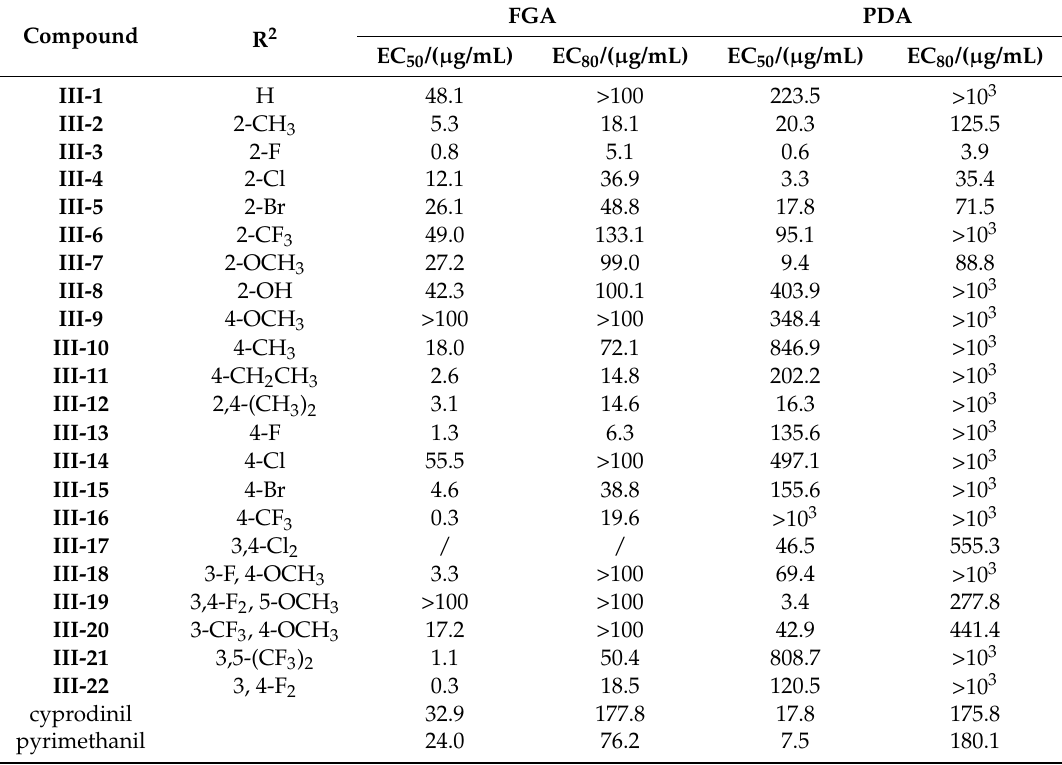
Table 1. The fungicidal activity of compounds III-1 – III-22 against B.